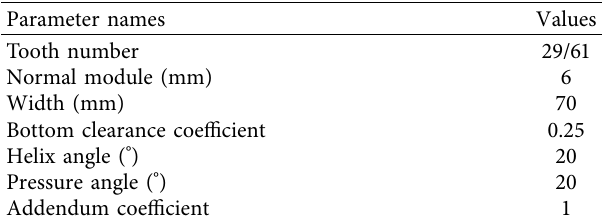
Table 1: Basic parameters of gears.